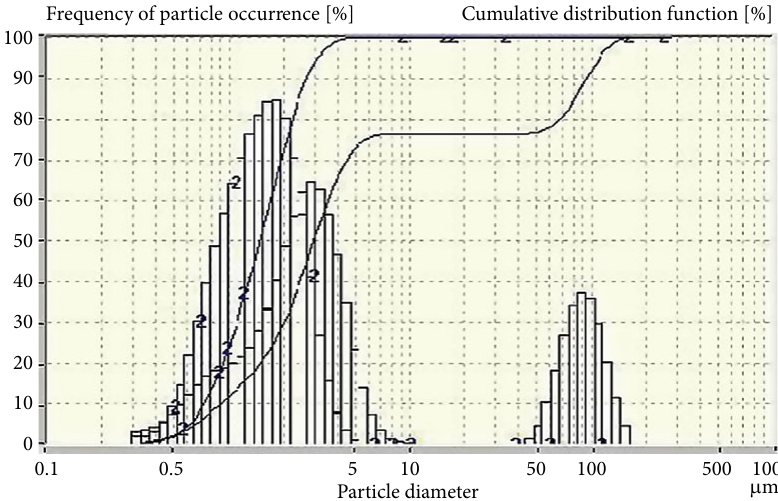
Fig. 1. Comparison of the frequency histograms and cumulative distribution functions of type E 160V55 epoxy dispersion particles, the first higher histogram and the first distribution function corresponding to the new